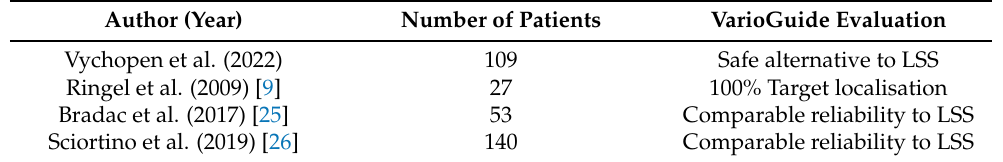
Table 3. VarioGuide comparative studies.